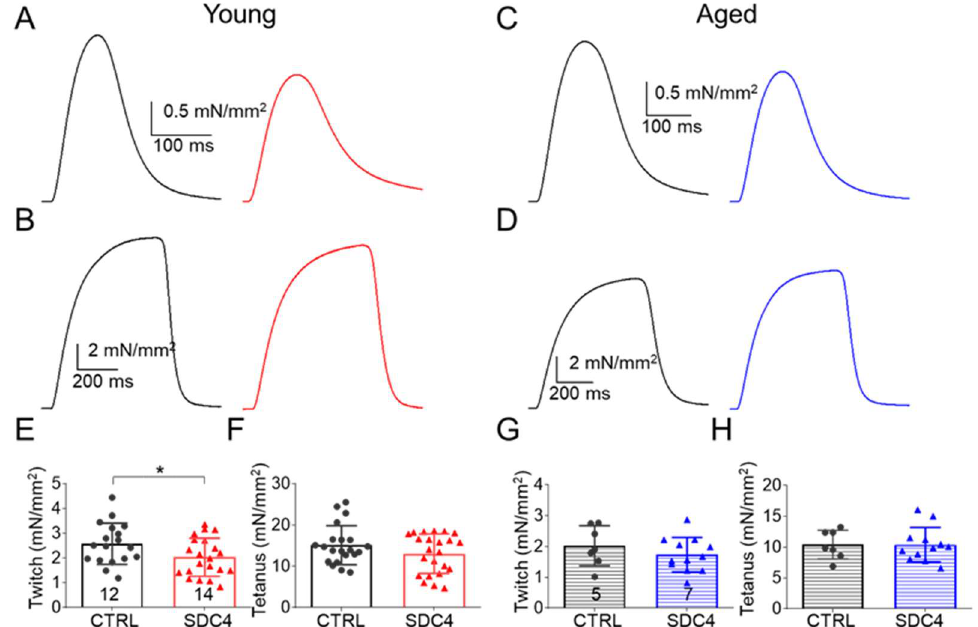
Figure 2. Representative ex vivo twitch ( A , C ) and tetanic ( B , D ) force on SOL muscle from young ( A , B ) and aged ( C , D ) CTRL (black) and SDC4 (red, blue) mice stimulated at 1 or 200 Hz, respectively, at room temperature (24 °C). Average twitch ( E , G ) and tetanic ( F , H ) force normalized to the cross- sectional area of the muscle. The numbers in the columns indicate the number of animals studied. * shows a significant difference from the age-matched CTRL at p <